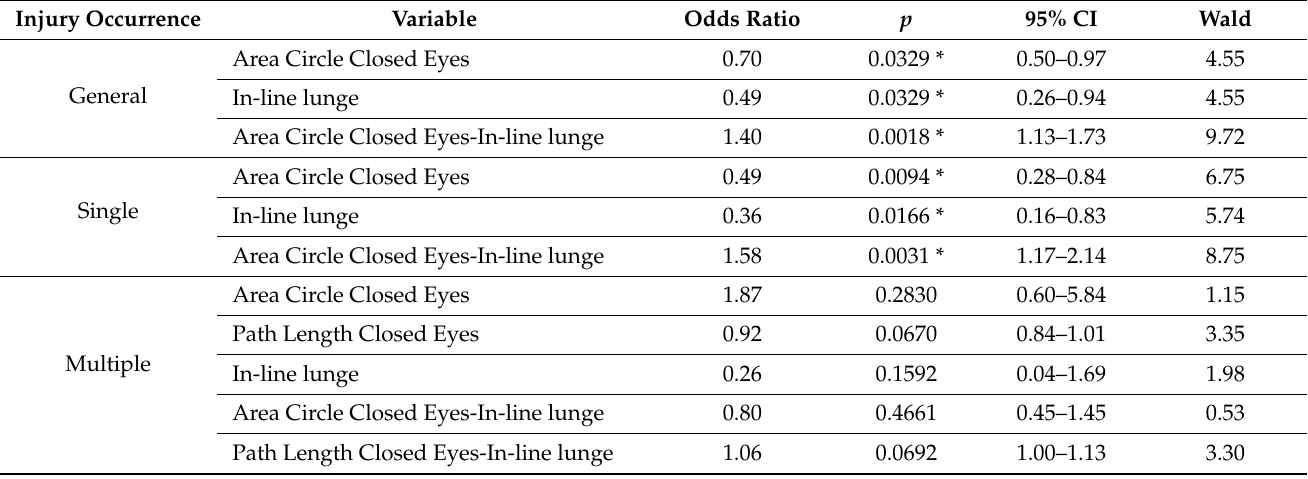
Table 4. The logistic regression model regards injury